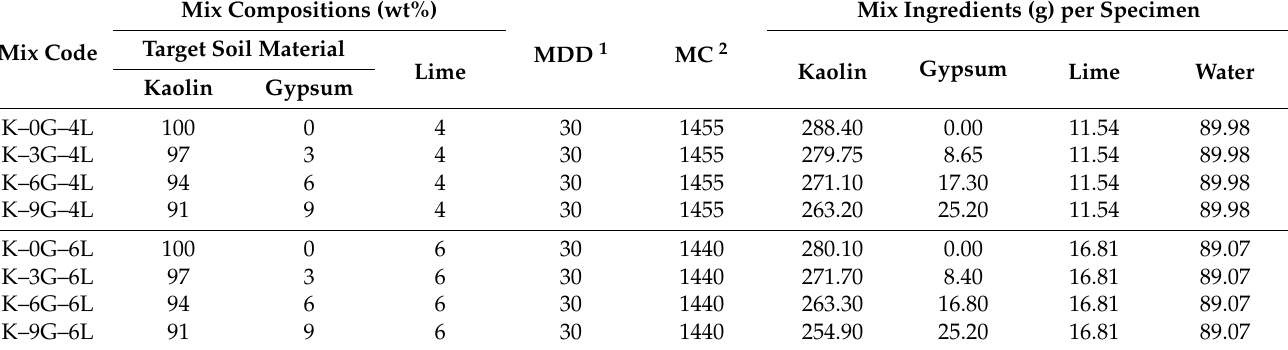
Table 2. Mix compositions of artificial sulfate-dosed kaolin specimens stabilised with two different lime dosages (4 and 6